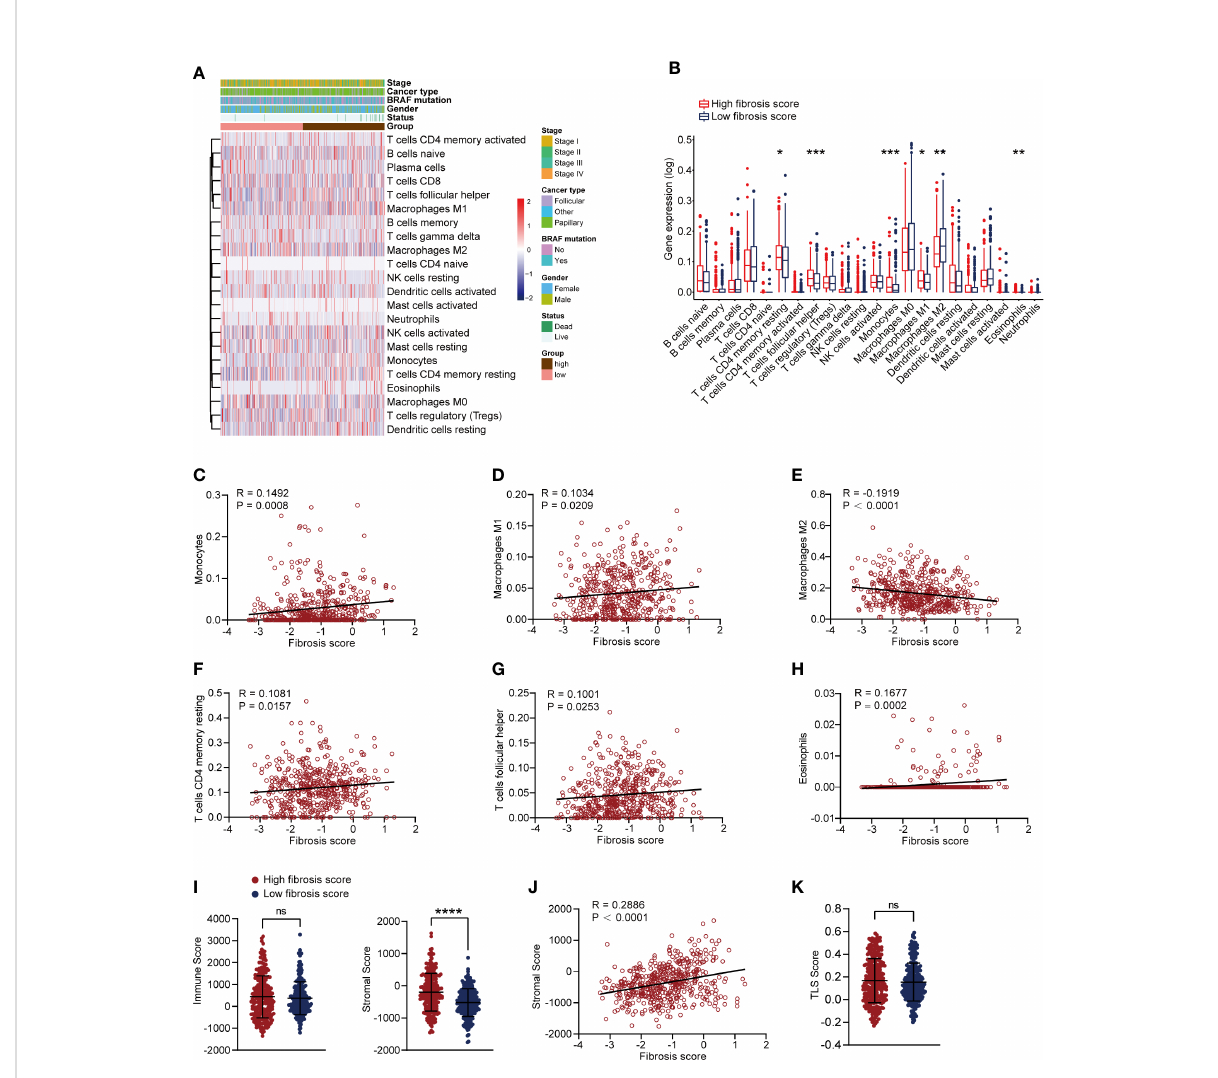
FIGURE 6 Correlation analysis of immune cells and fi brosis scores in thyroid cancer patients. (A) The heatmap of immune cells in fi ltration and clinical features in thyroid cancer patients. (B) Comparing the in fi ltration levels of immune cells between high and low fi brosis score patients. (C – H) Correlation analysis between fi brosis scores and monocytes, M1 macrophages, M2 macrophages, CD4 memory resting T cells, follicular helper T cells and eosinophils. (I) Stromal scores were increased in high fi brosis score group, but no signi fi cant difference was found in immune scores. (J) Stromal scores were positively correlated with fi brosis scores in thyroid cancer patients. (K) No signi fi cant difference of TLS score was found between high and low fi brosis score groups. *P < 0.05; **P < 0.01; ***P <